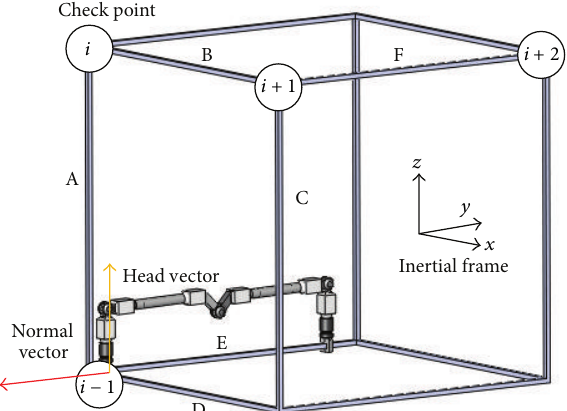
Figure 17: An example illustrating the computation of individual